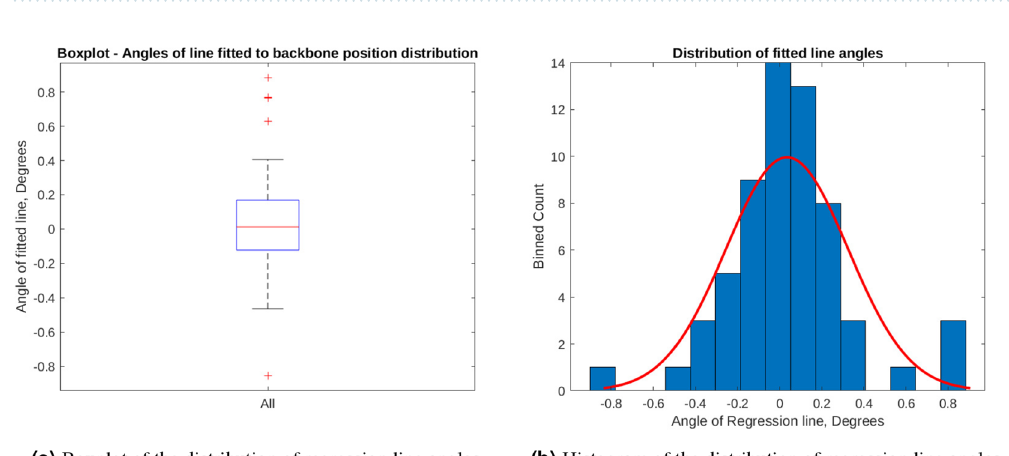
Figure 3. ( a , b ) The collections of distances were appropriately binned, plotted as histograms and a normal distribution was fitted. (The same data was used as in Fig. 2b.) This indicates that the distribution of the distances is not biased and that the mean value was a reasonable choice for the backbone radius. (MATLAB, 2020b, https:// www. mathw orks. com/).